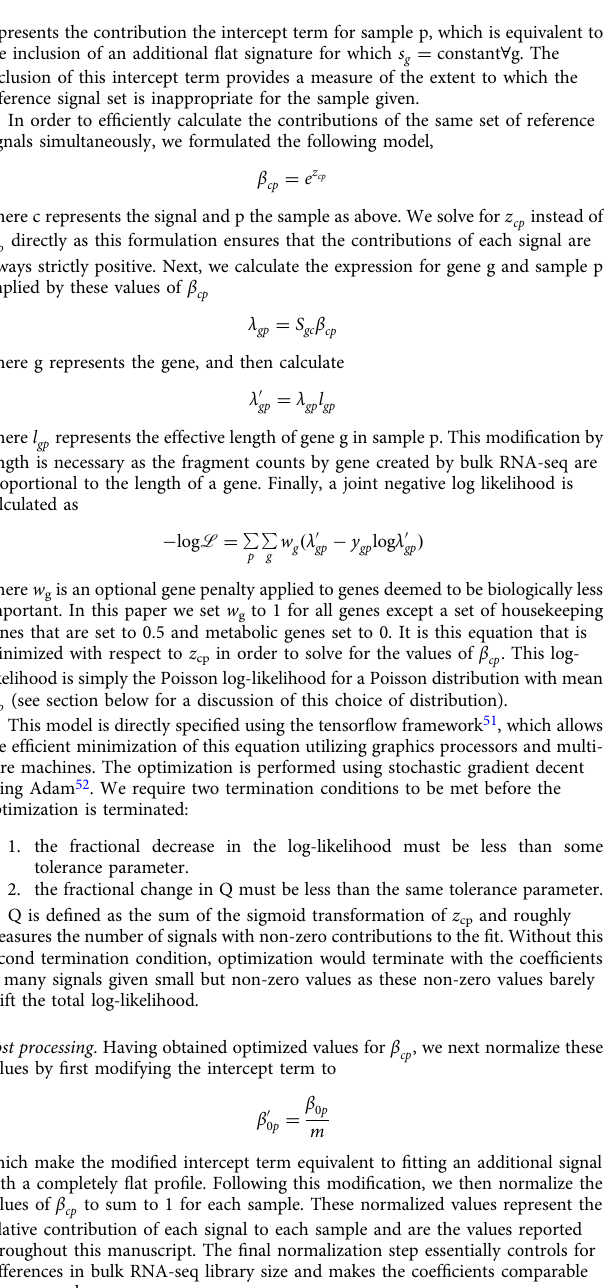
Fig. 7 Clinical utility of cellular signal analysis. A Sensitivity/Speci fi city of signals in classifying tumor types: Curves showing the sensitivity and speci fi city of using the scores de fi ned by the color scheme to classify tumors by type at different cut-offs. The different score and tumor type pairs are: fetal interstitial cells and CMN (light blue), intercalated cells and ChRCCs (dark blue), developing nephron and Nephroblastoma (light green), PT1 and ccRCCs/pRCCs (dark green), and mature vascular and ccRCCs (red). B Median reference contribution by tumor type: Each point represents the median score for the group of samples indicated by the combination of shape (tissue type, see legend) and shading (score type, as in A ). C Histology image of unclassi fi ed childhood renal tumor: The tumor mostly compromised pleomorphic epithelioid cells that formed tubules, papillae, glands and nests, as well as more solid areas with spindled cells and clefting similar to that of synovial sarcoma. Patchy tumor necrosis was apparent. Some areas showed smaller, more uniform cells lining narrow tubular structures, resembling adenomatous perilobar nephrogenic rests. Overall, the morphology and ancillary tests were inconclusive. Scale bars at bottom of each image indicate approximately 100 μ m. D Immaturity score for unclassi fi ed childhood renal tumor: Calculated as in Fig. 2, with score range for normal post-natal kidney indicated on left. E Summary of signal contribution from fetal and mature kidney to unclassi fi ed childhood renal tumor: Each color represents the signal type labeled and fraction of squares of each type matches the signal contribution. F Immaturity score for childhood renal cell carcinoma: As in D . G Summary of signal contribution from fetal and mature kidney to childhood renal cell carcinoma: As in E but for a transcriptome derived from renal cell carcinoma fi t using a mature kidney signal set. Source data are available as a Source Data fi